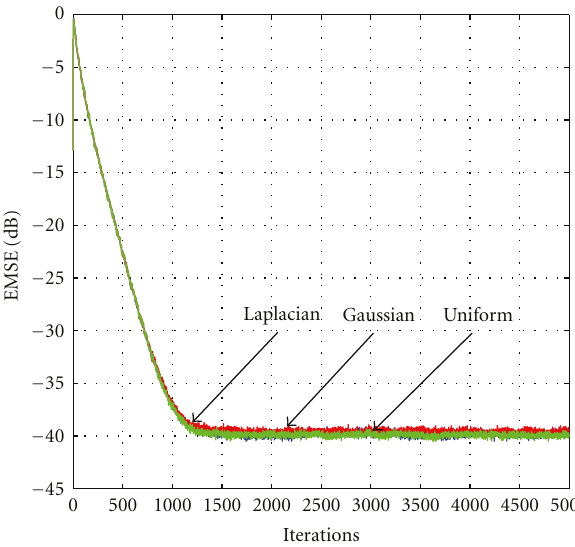
Figure 10: Learning curves of the proposed algorithm in di ff erent noise environments scenarios for α = 0 . 8 and SNR of 20